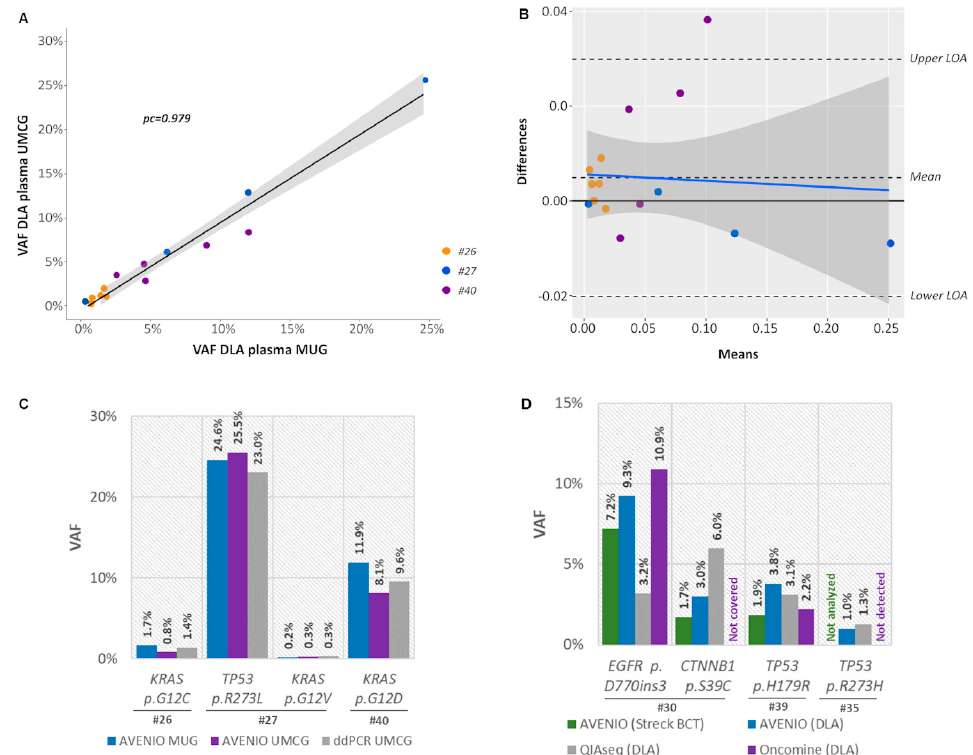
Figure 6. The use of DLA plasma for inter-laboratory and -assay comparison. ( A ) Shown is a linear regression of variant allele frequencies (VAF) of mutations identified in plasma collected from Streck BCT and corresponding DLA samples using the AVENIO Expanded Kit including the 95% CI (gray). pc, Lin's concordance correlation coefficient. ( B ) Bland–Altman plot of differences between VAFs obtained at MUG and UMCG versus the mean of the two measurements with upper and lower limits of agreement (upper/lower LOA, 95%). There was only one outlier outside the LOA resulting in a bias of 0.0049. VAFs from different patients are plotted using a different colored symbol. ( C ) VAFs of KRAS codon 12 and TP53 codon 273 mutations validated by ddPCR ( D ) VAFs of variants detected in DLA and Streck BCT plasma using AVENIO Expanded Kit, the Oncomine Lung cfDNA Assay and the QIAseq Human Actionable Solid Tumor Assay.